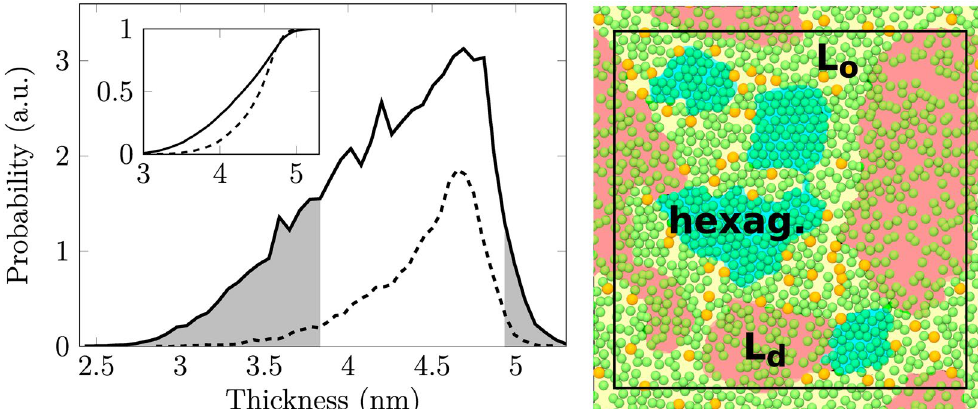
Figure 3. Left: Thickness histogram for the Chol10 316 system. The inset shows the normalized cumulative distributions. Solid lines show data collected from the whole system and dashed lines data collected from locations occupied by cholesterol. Grey fill highlights regions with a small local concentration of cholesterol. Right: The proposed domain structure; DPPC chains are shown in green and cholesterol in orange. The estimated locations of lipids displaying L o -like, L d -like, and hexagonally packed regions are shaded with yellow, red, and blue, respectively. The simulation box is drawn in